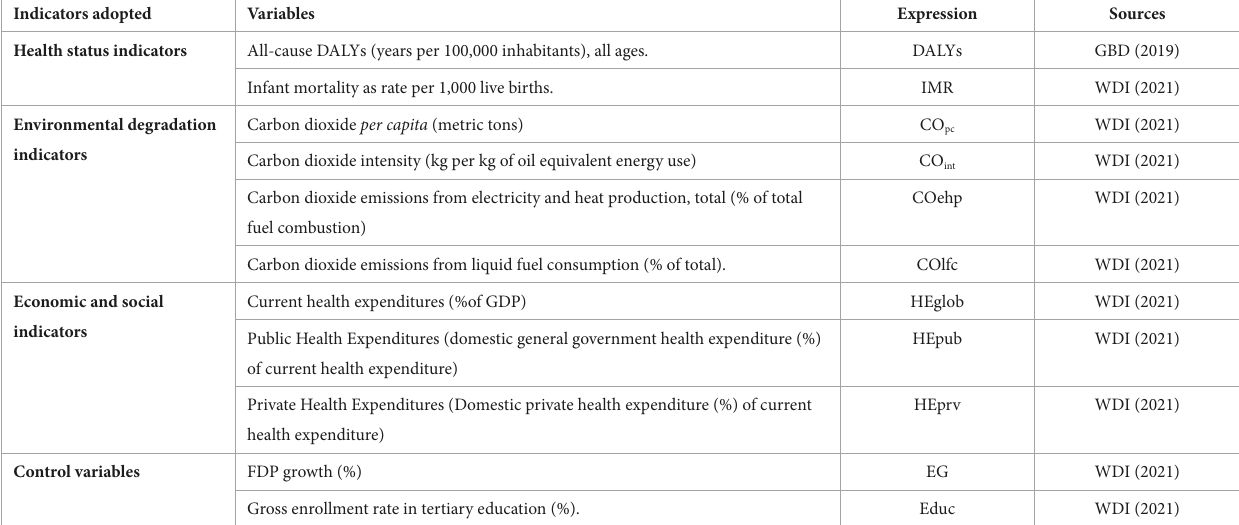
Table A.1. Data source and expected signs of each